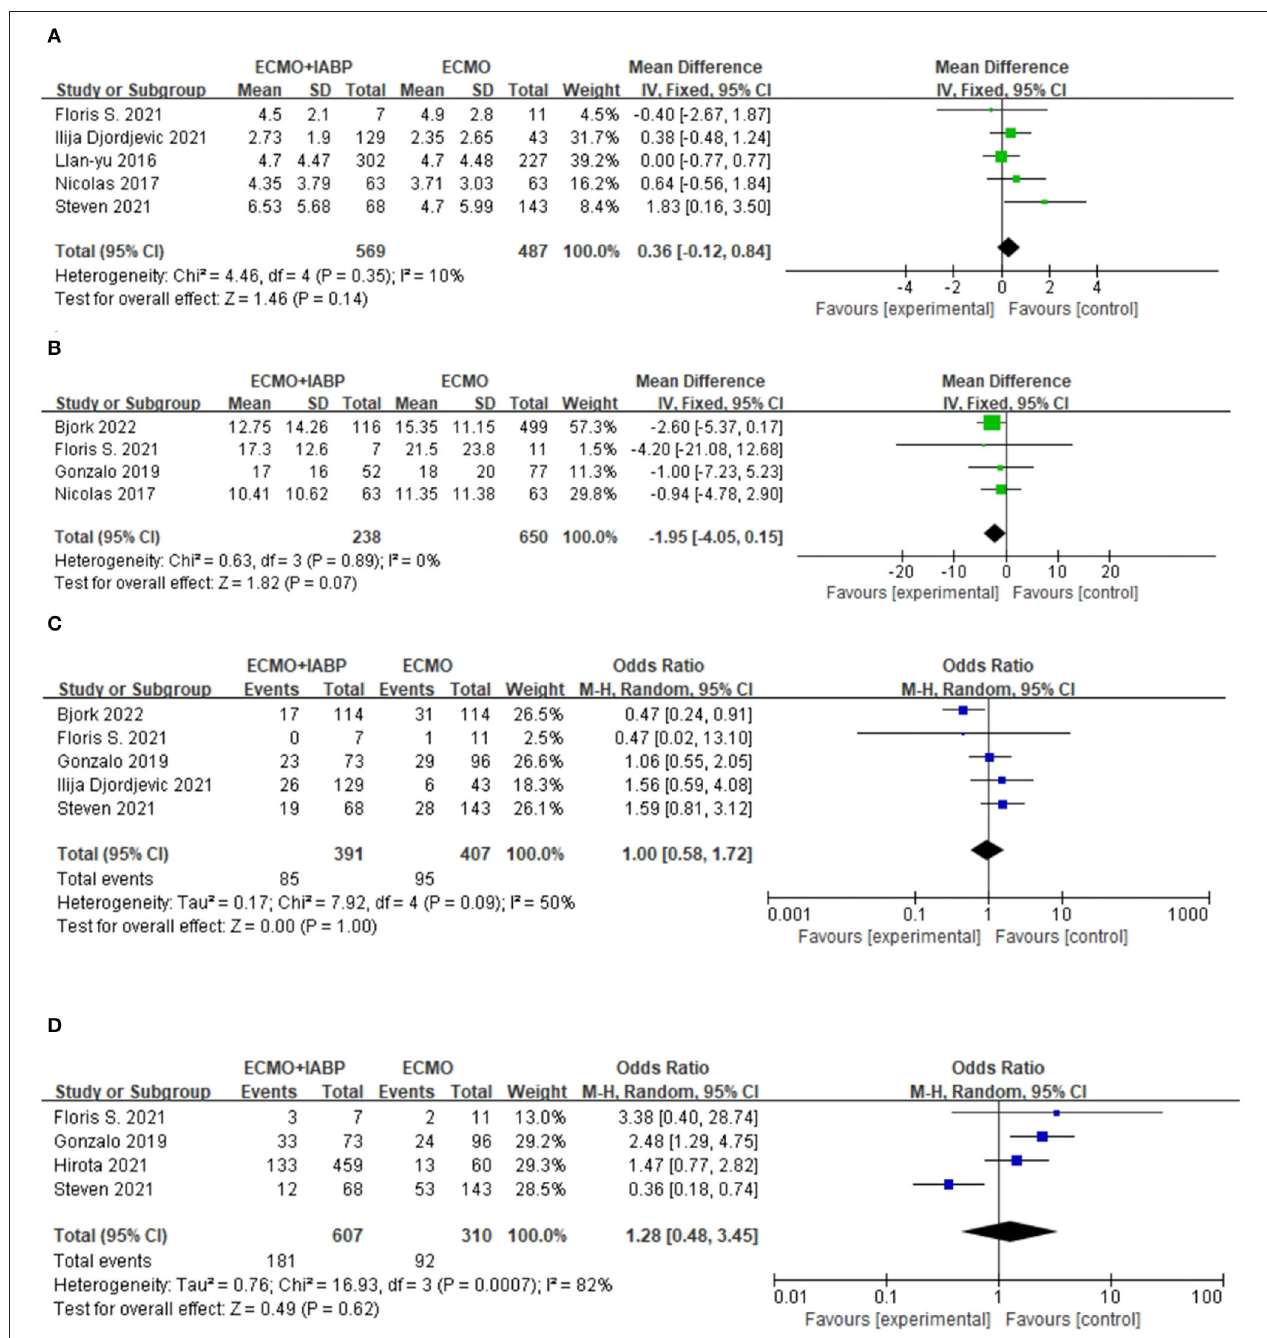
FIGURE 4 | Forest plots of this meta-analysis. Duration of ECMO (A) , Duration of ICU (B) , Infection/sepsis (C) , and Bleeding (D) . ECMO, extracorporeal membrane oxygenation; IABP, intra-aortic balloon